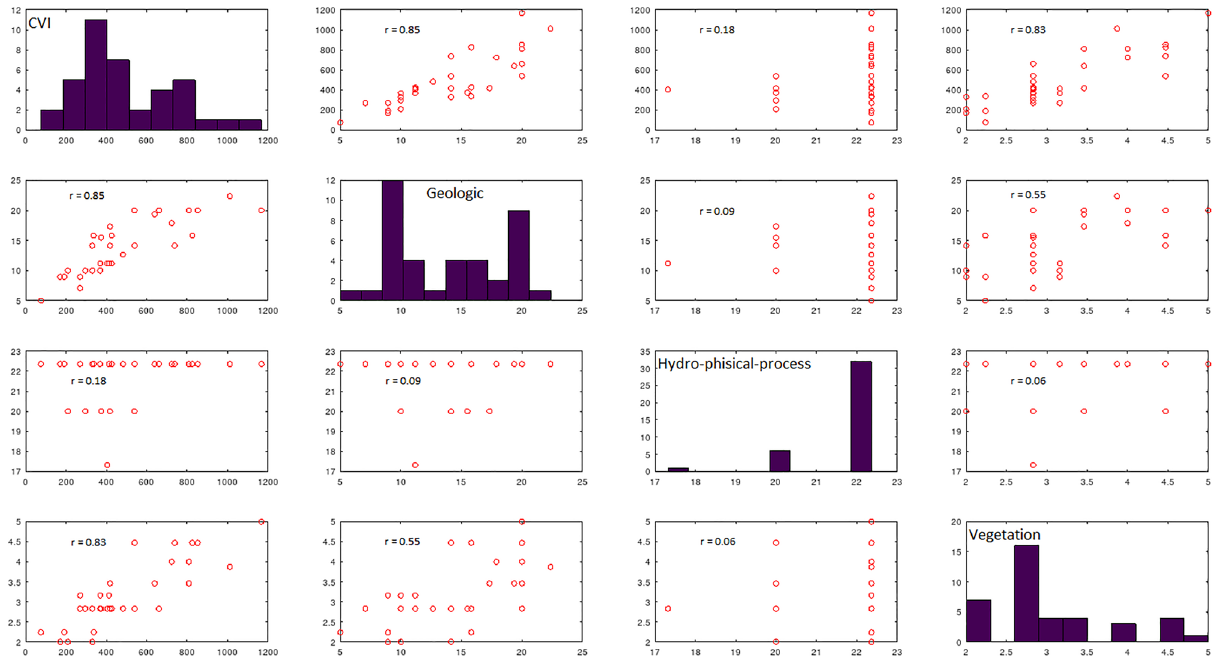
Figure 3. The scatter plot shows the results of Pearson’s product-moment correlation considering the three groups of variables and the overall CVI value with the correlation coefficient value (r) highlighted.